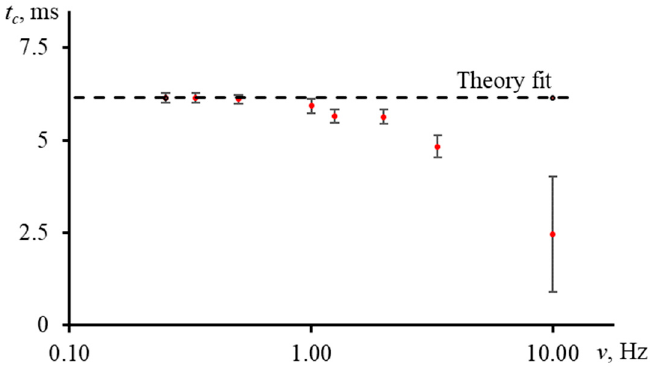
Figure 17. Characteristic time for an aqueous solution of ferroin (2.5 µ mol/L) as a function of the modulation frequency; narrow-focused configuration ( ω e 0 = 33 µ m, Figure 1, Table